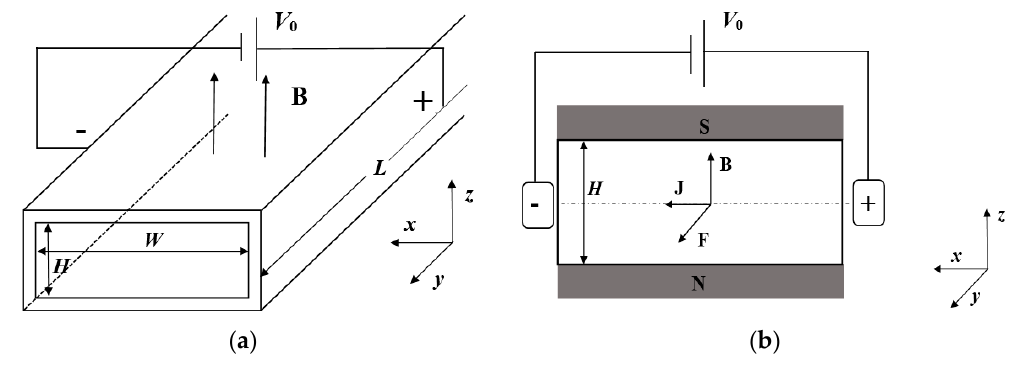
Figure 1. Schematic diagram of a rectangle electromagnetically-driven microchannel. ( a ) Three-dimensional model schematic; ( b ) Two-dimensional schematic diagram of x – z cross-section.